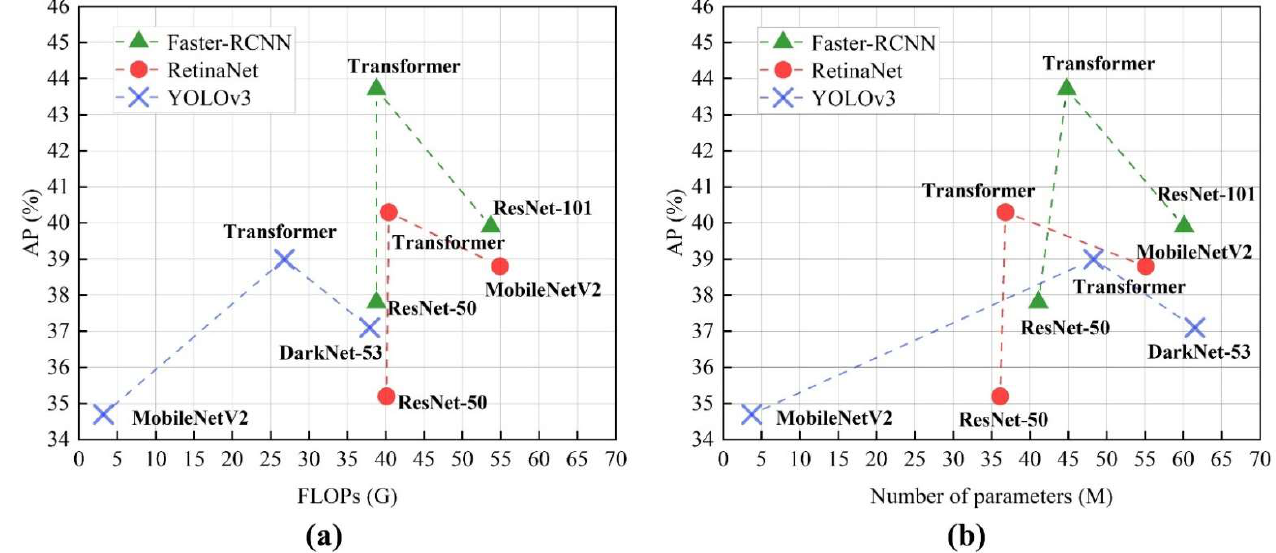
Figure 8. Results of wheat heads using different backbones to detect UWHD. Focus on the difference in FLOPs and AP for each method ( a ); also, compare number of parameters and AP ( b ).